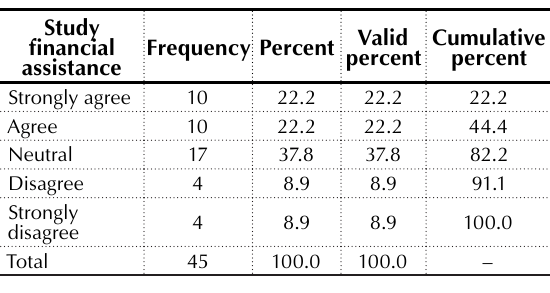
Table 5. Responses on study financial assistance